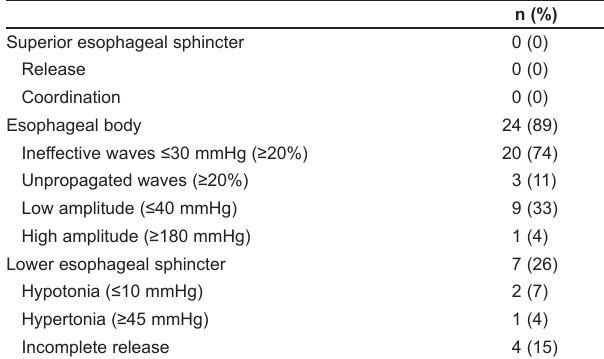
TAble 2 Anomaly types in the abnormal esophageal